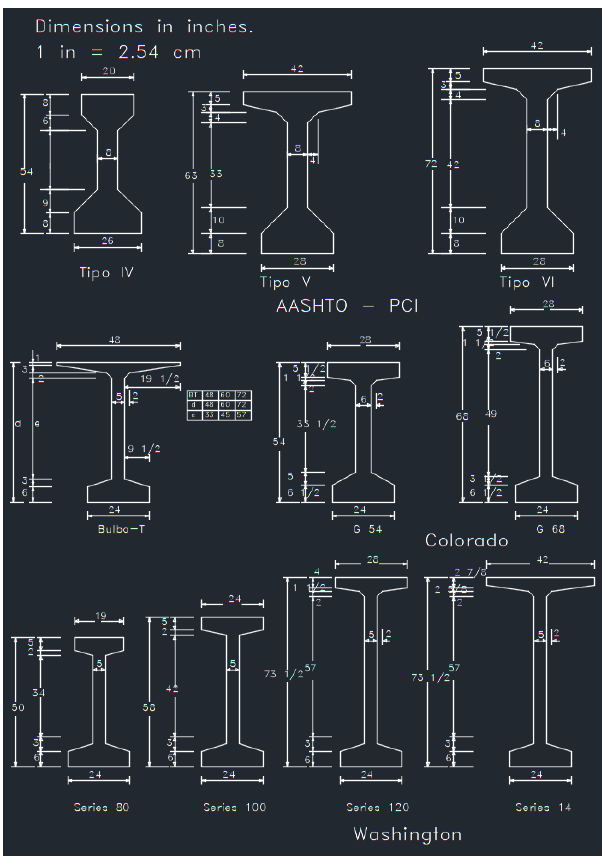
Figure 2. Modified girder analyzed (AASHTO, Bulb T, Colorado and